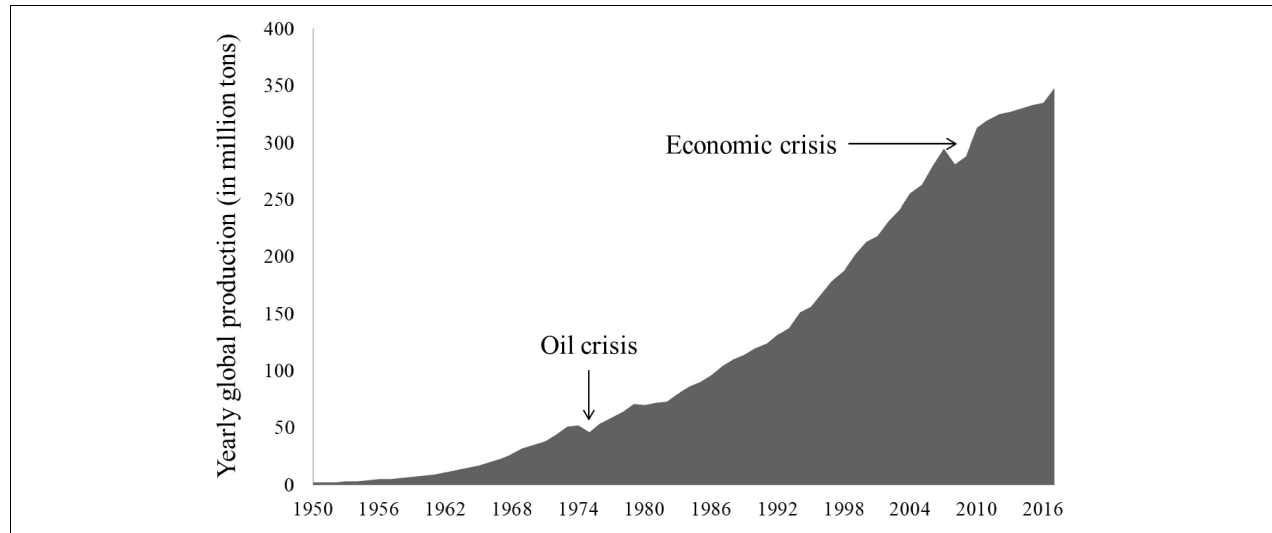
FIGURE 1 | The yearly global production of plastics, from 1950 to 2017. Adapted from Schlanger (2018).